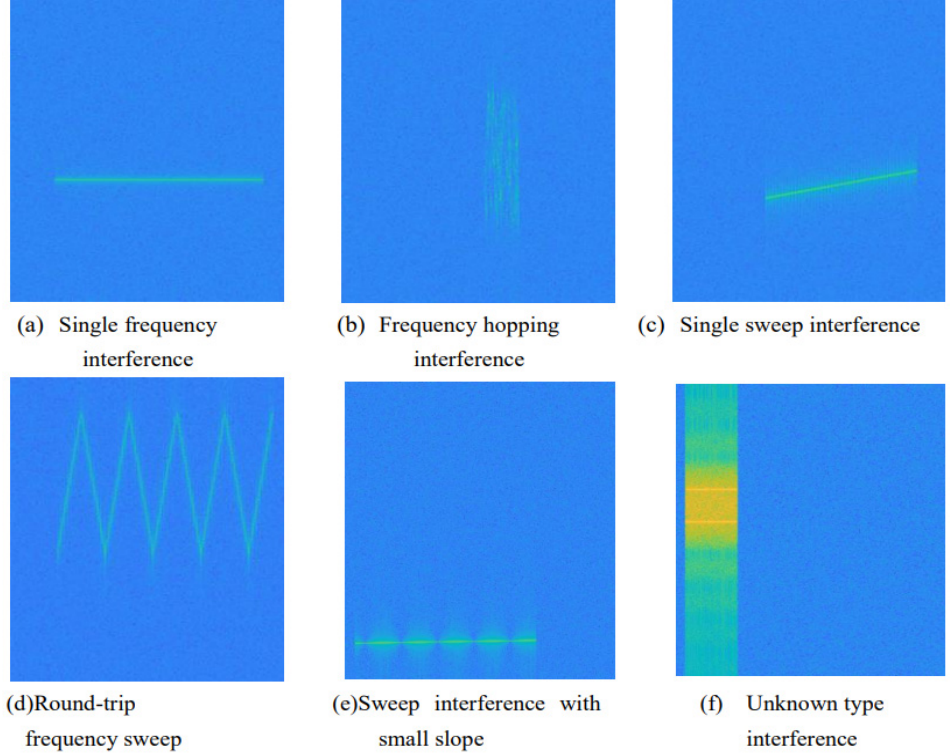
Figure 5. Time frequency diagram of six kinds of interference. ( a ) Single frequently interference, ( b ) Frequency hopping interference, ( c ) Single sweep interference, ( d ) Round-trip frequency sweep, ( e ) Sweep interference, ( f ) Unknown type interference.